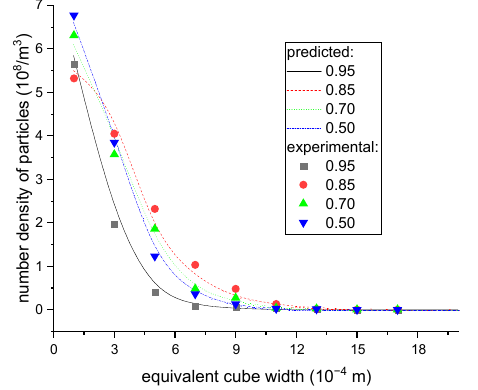
Figure 12. The equivalent cube size distributions of particles in the final products under different operating conditions.